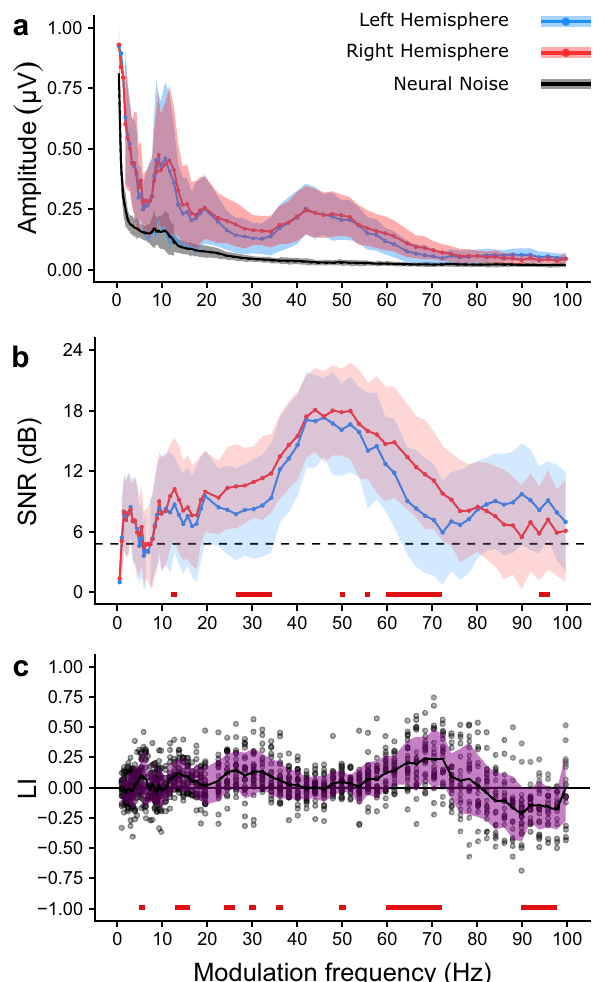
Figure 3. The group average biased ( a ) amplitude, ( b ) signal-to-noise ratio (SNR), and ( c ) laterality index as a function of modulation frequency. The mean is represented by the solid line and the shaded area reflects the range between the mean ± one standard deviation. The solid black line and the gray area in panel A show the average neural background noise across channels ± one standard deviation, respectively. The individual LIs are represented by the dots in ( c